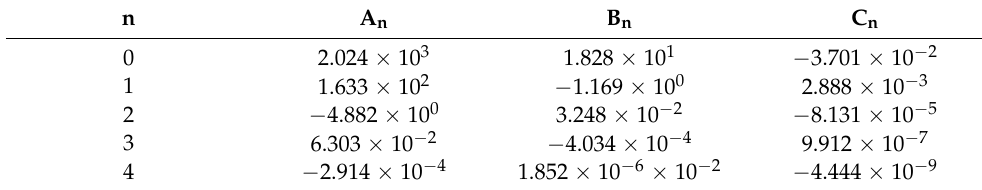
Table A3. Coefficients of the H 2 O-LiBr enthalpy equation.